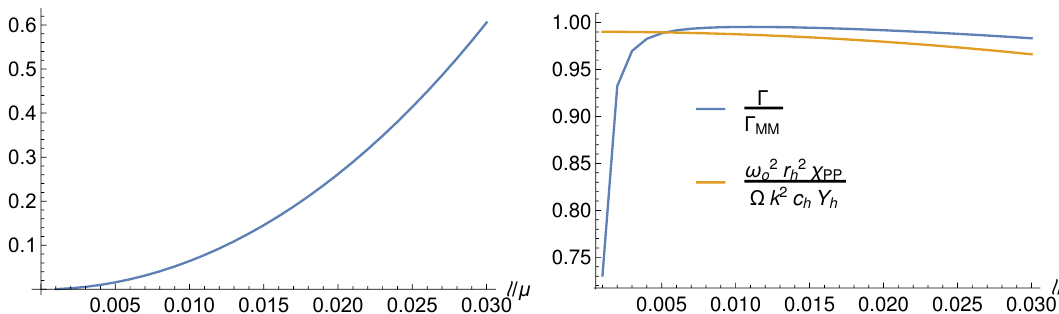
Figure 8 . ( (cid:21)=(cid:22); k=(cid:22); T=(cid:22) ) = (2 (cid:2) 10 (cid:0) 4 ; 0 : 1 ; 0 : 1). Left: ‘ dependence of the ratio (cid:0) = ( ! 2 comparison between (cid:0), ! 2 = (cid:10) and their approximate memory matrix o